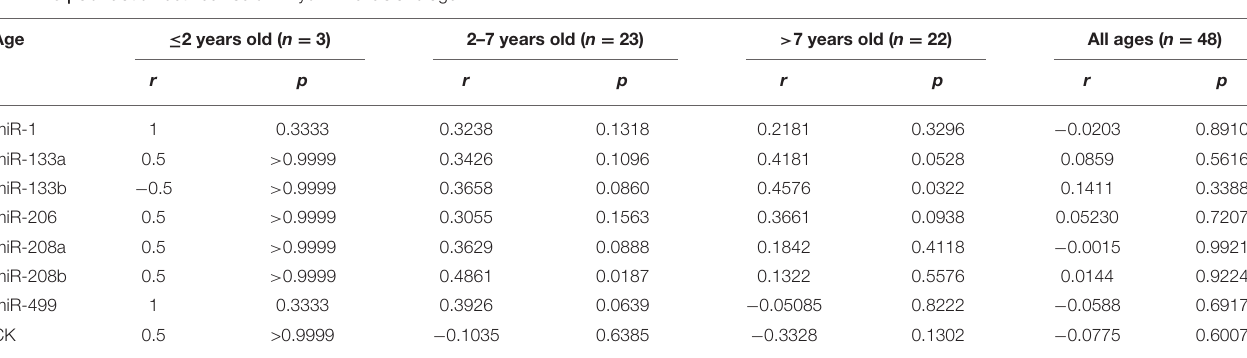
TABLE 3 | Correlation between serum myomiR levels and